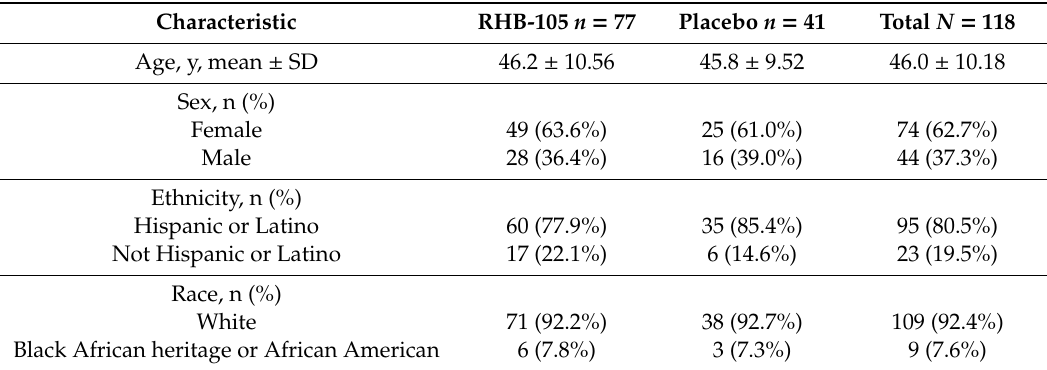
Table 1. Baseline subject demographics and characteristics.